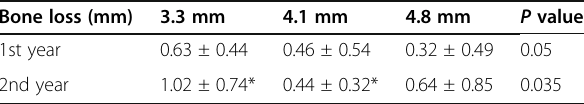
Table 4 Marginal bone loss of implants in different diameters Bone loss (mm)